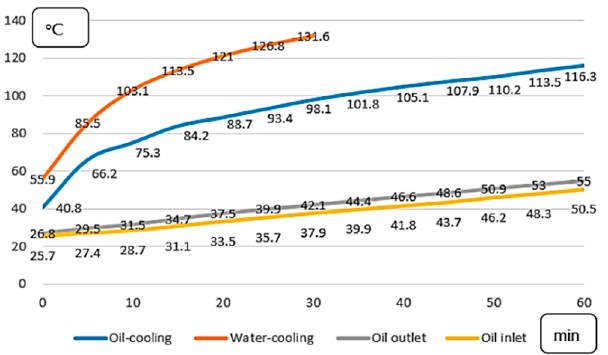
Figure 20. Contrast between water-cooled motor and oil-cooled motor based on the test results